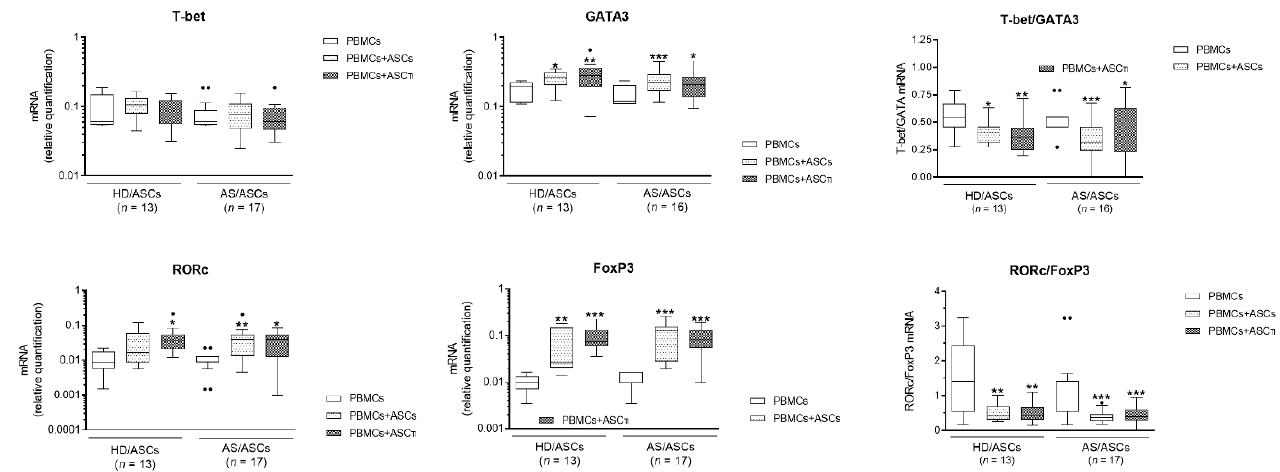
Figure 2. Changes in the expression of Th subset specific transcription factors in the co-cultures of ASCs with PBMCs. Explanations as in Figure 1, except that 5 HD/ASCs and 11 AS/ASCs lines were co-cultured with PHA-stimulated PBMCs that were isolated from peripheral blood of 13 healthy donors. The ASCs-PBMCs co-cultures were performed using a random combination of both cell types and the number of experiments is shown ( n ). Results are expressed as the median (horizontal line) with interquartile range (IQR, box), lower and upper whiskers (data within 3/2xIQR), and outliers (points/dots) (Tukey’s box). * p < 0.05; ** p < 0.001; *** p < 0.0001 for intra-group comparison (PBMCs vs. PBMCs + ASCs or ASCsTI); the inter-group differences were statistically insignificant.